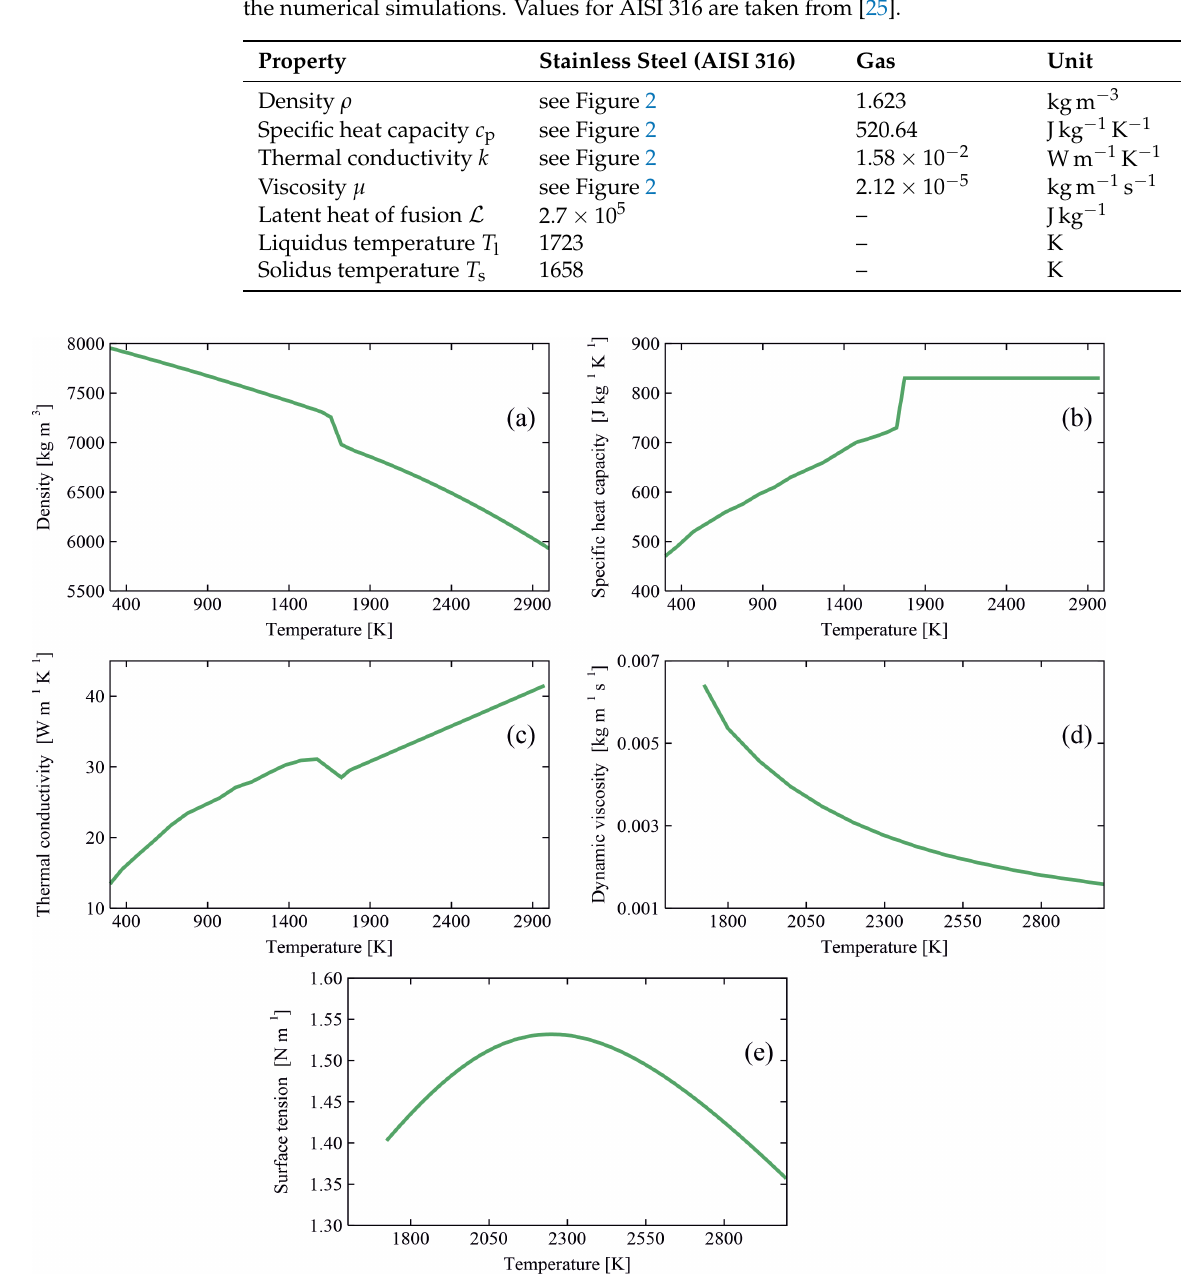
Figure 2. Temperature-dependent thermophysical properties of AISI 316L employed in the simulations. ( a ) density [26], ( b ) specific heat capacity [25], ( c ) thermal conductivity [25], ( d ) dynamic viscosity [26] and ( e ) surface tension